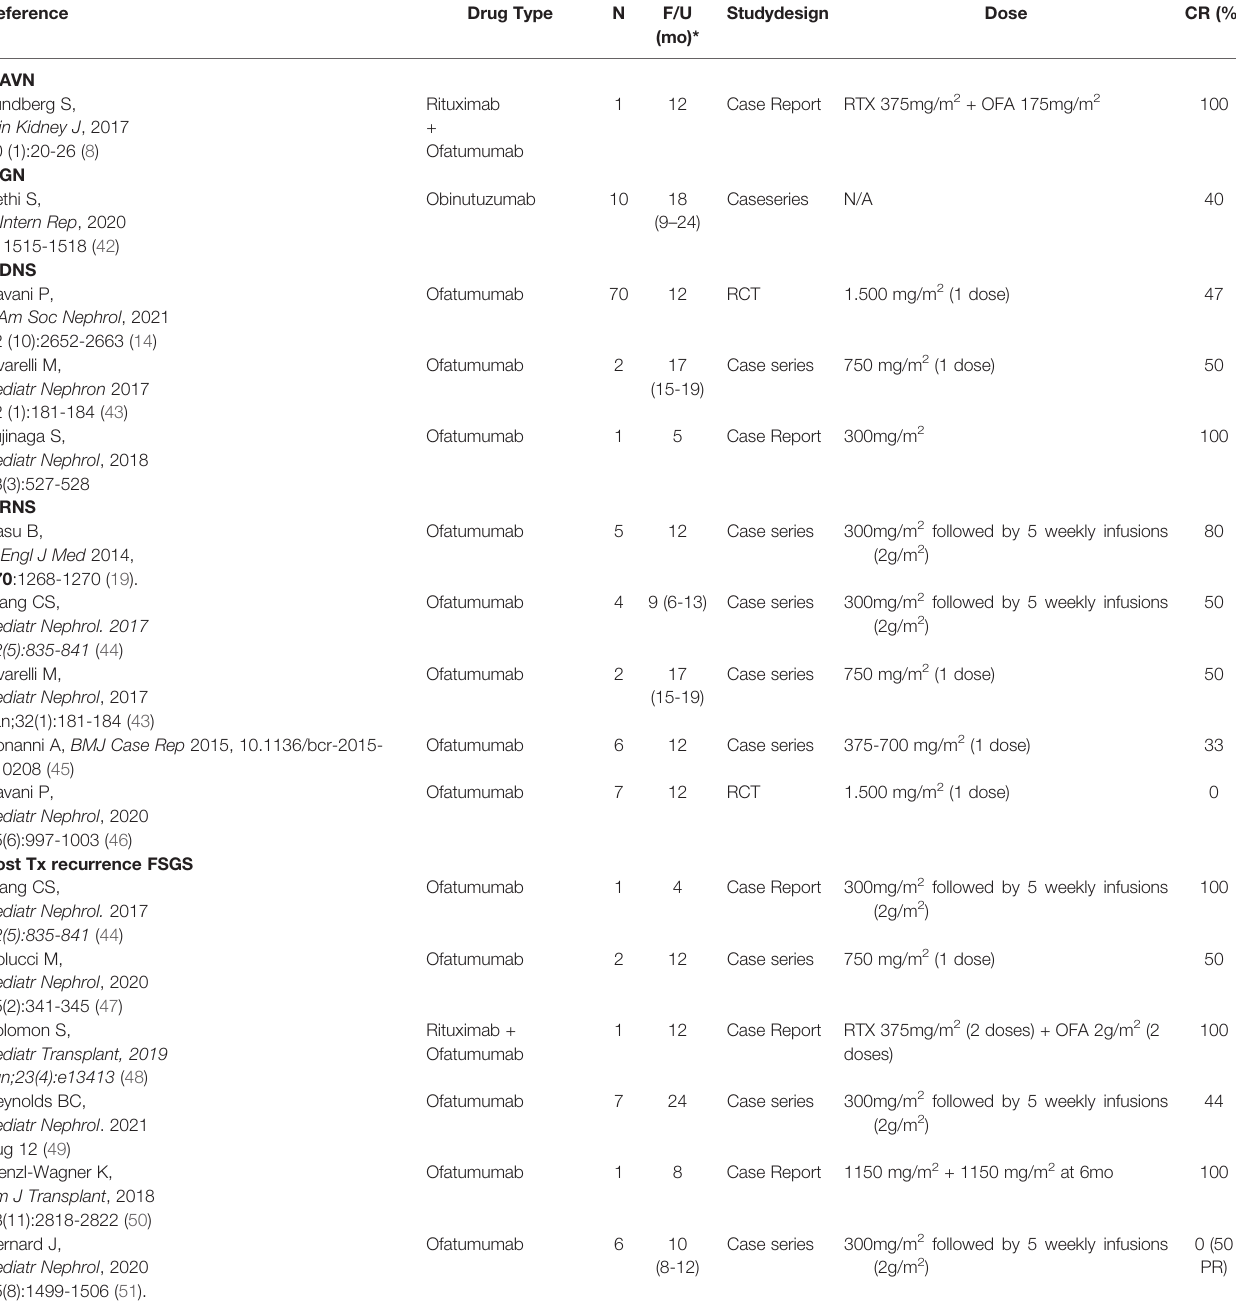
TABLE 2 | Main studies reporting administration of humanized anti-CD20 in nephrotic